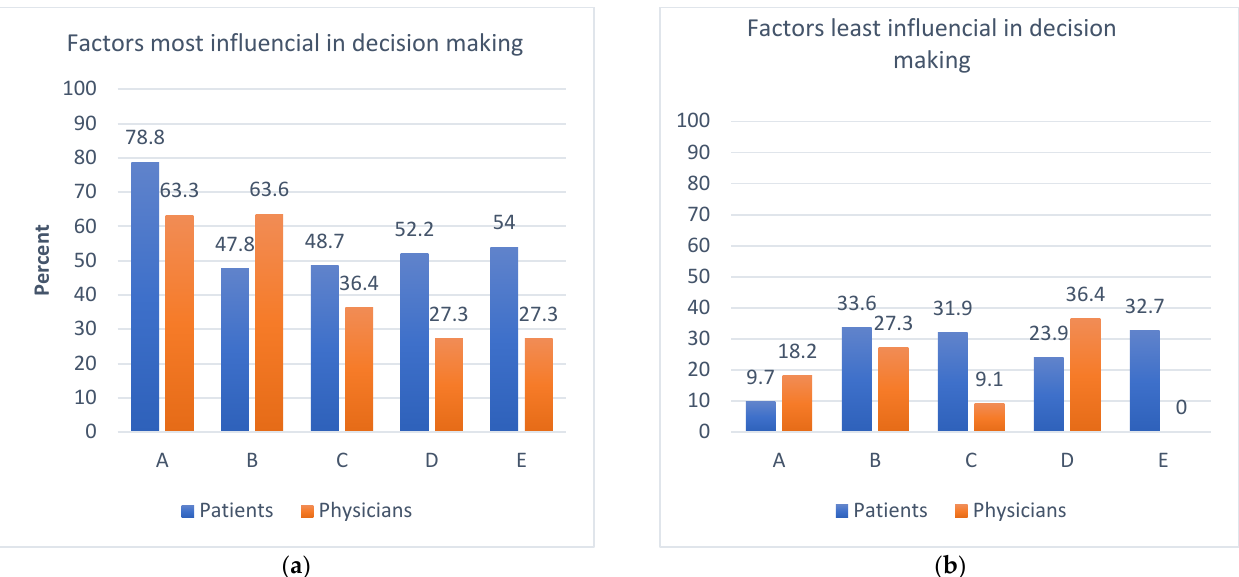
Figure 3. Patient vs physician interest in genomic testing. Responses to questions, respectively: Of the following listed factors, which would ( a ) most and ( b ) least influence you in a decision to pursue genomics testing in the care of your cancer patients? A. Potential to guide treatment selection; B. Potential to predict disease outcome; C. Potential to inform side effects management; D. Potential to learn more about my cancer; E. Desire to contribute to scientific research.